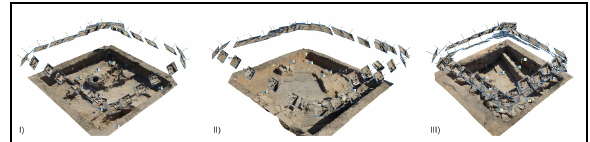
Figure 9 . Overview of the GCPs and the terrestrial image data (DSLR Canon EOS 1200D, 4/7/2019) after the image orientation in AgiSoft PhotoScan software of the: (I) first, (II) second, (III) third archaeological trench.